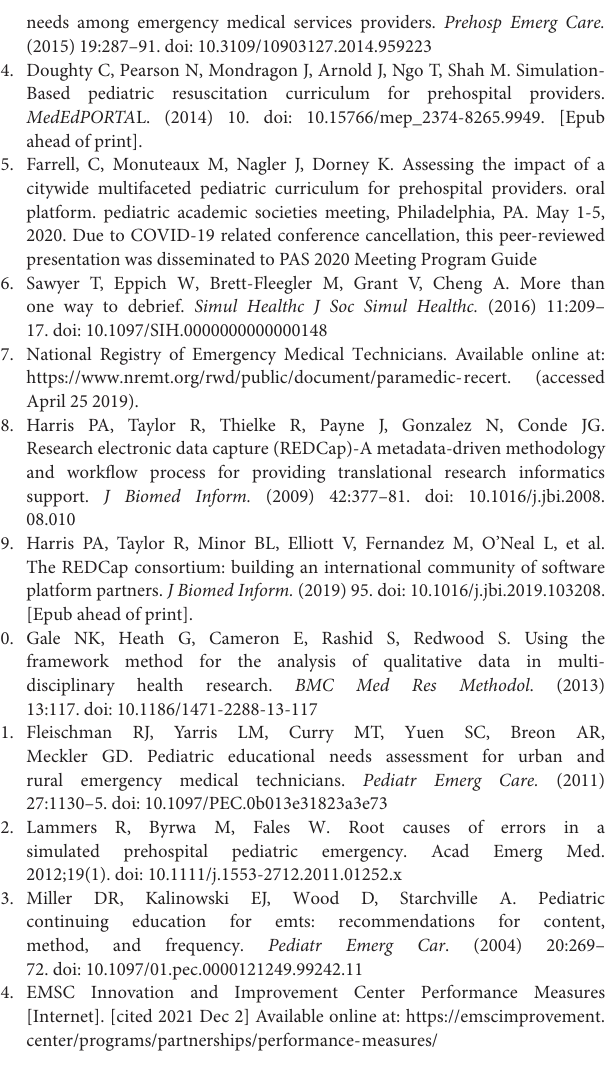
Supplementary Figure 1 | Schedule of the